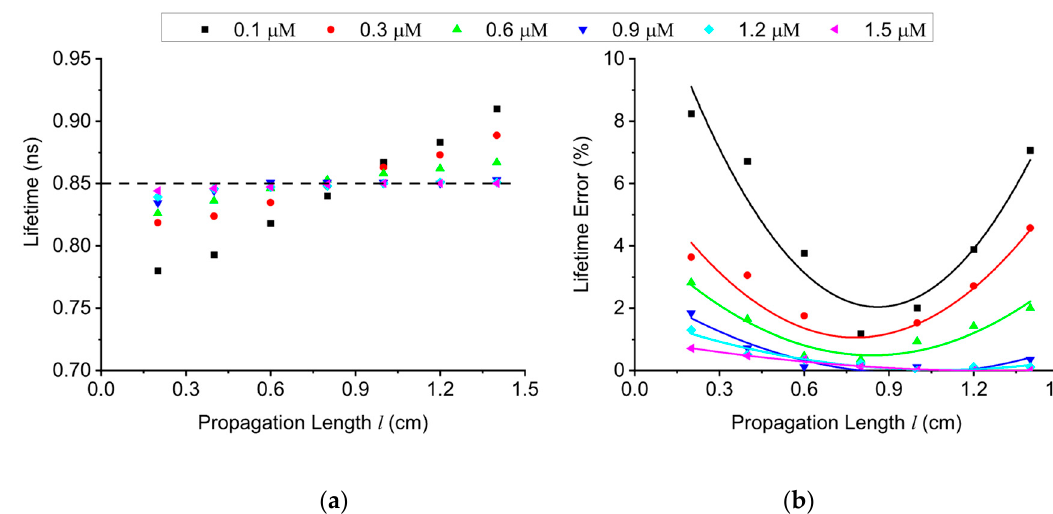
Figure 6. Monte Carlo simulation of extracted lifetime across V-carbazole concentrations, modeling time dispersion within the liquid core waveguide. ( a ) Lifetime extracted with different values of propagation length l , compared to the ideal value of 0.85 ns; ( b ) lifetime error at different propagation lengths, suggesting the optimal l is approximately 0.8 cm.